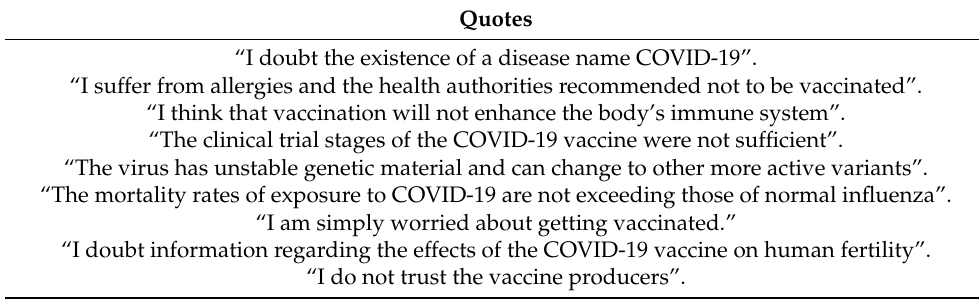
Table 6. Quotes from those not willing to participate in a COVID-19 vaccination campaign.